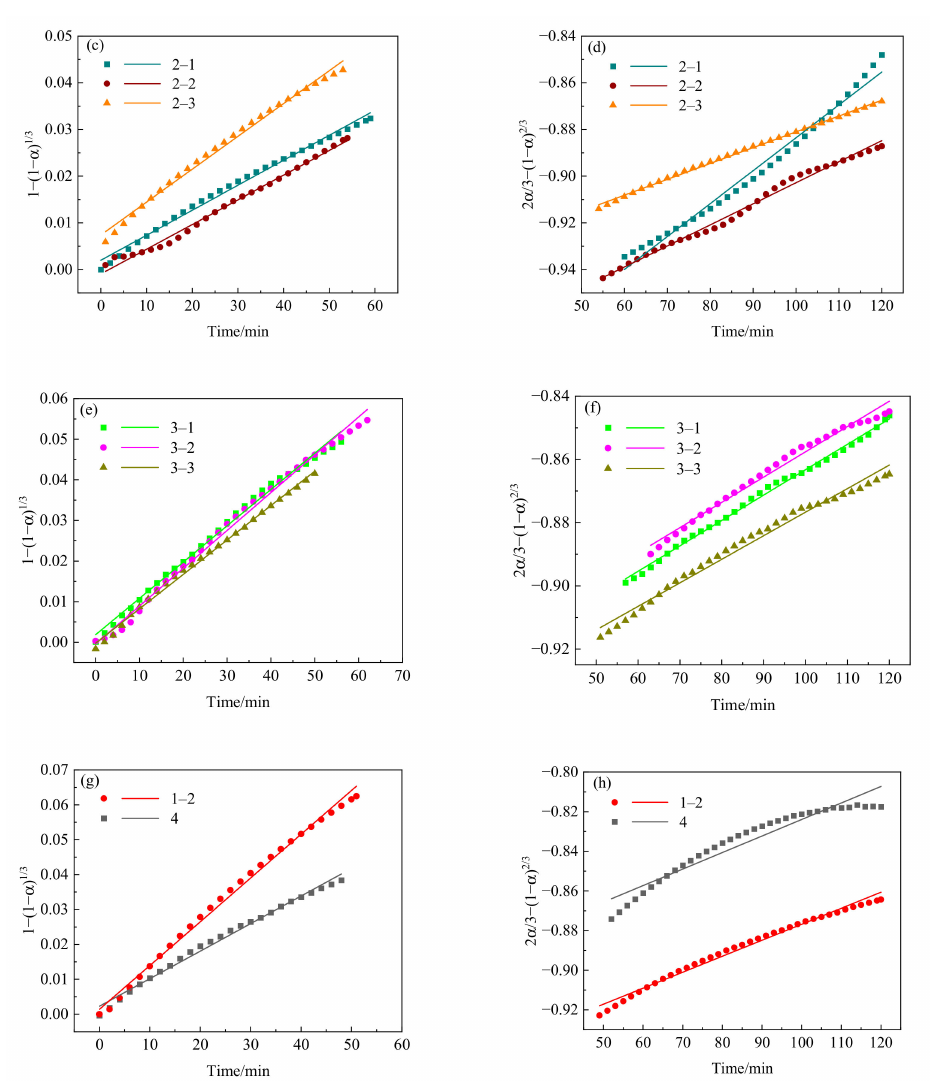
Figure 4. Fitting results of sectioning method. ( a ) Chemical-reaction speed control of the first group experiment; ( b ) Internal-diffusion control of the first group experiment; ( c ) chemical-reaction speed control of the second group experiment; ( d ) internal-diffusion control of the second group experiment; ( e ) chemical-reaction speed control of the third group experiment; ( f ) internal-diffusion control of the third group experiment; ( g ) chemical-reaction speed control of the fourth group experiment; ( h ) internal-diffusion control of the fourth group